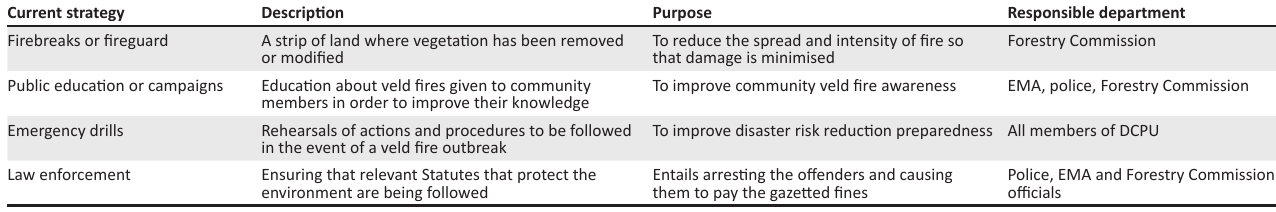
TABLE 4: Intervention strategies used by the Mangwe District Civil Protection Unit. Current